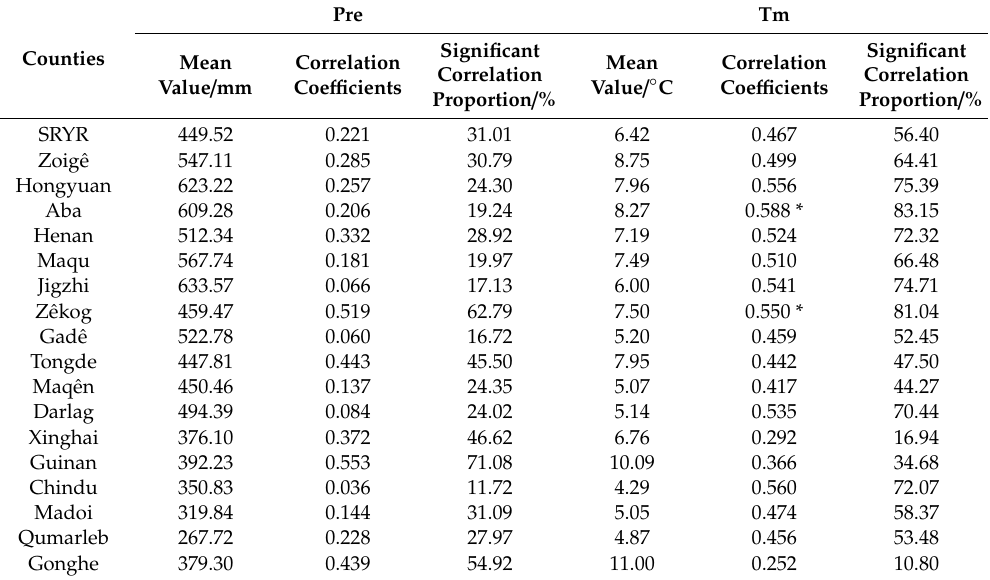
Table 3. Climate elements and correlation coe ffi cients in di ff erent